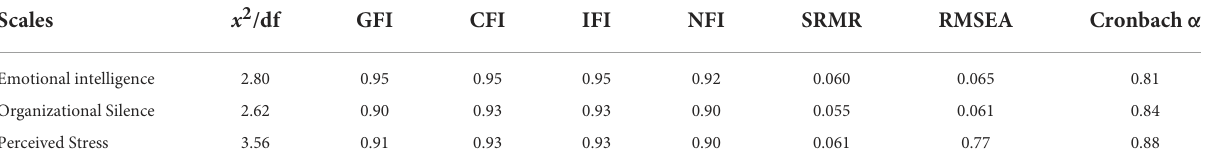
TABLE 1 Confirmatory factor analysis results of the scales used in the research. Scales x 2 /df Emotional